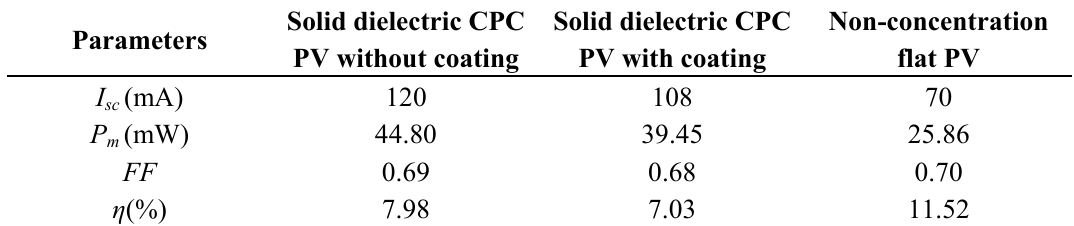
Table 1. Performance parameters of CPCs with the incidence angle of 0°.